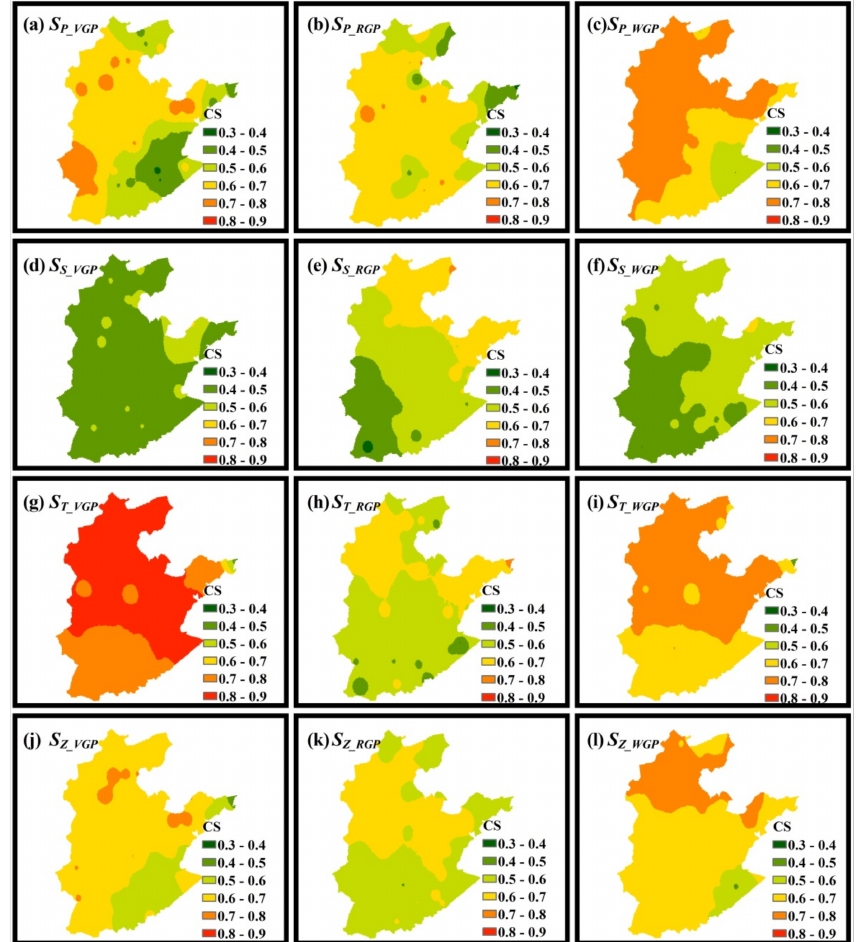
Figure 4. The spatial distribution of maize climate suitability for the vegetative growth period ( a , d , g , j ), reproductive growth period ( b , e , h , k ) and whole growth period ( c , f , i , l ) during the baseline period (1981–2010) in the North China